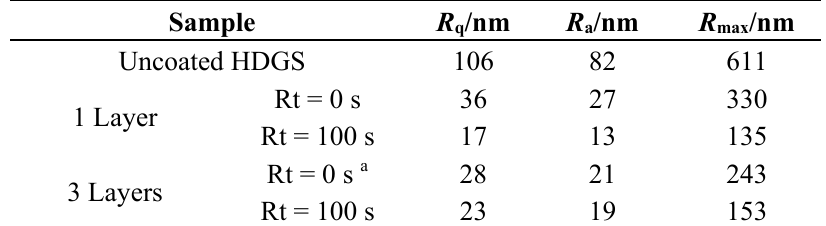
Table 3. Roughness parameters obtained for uncoated (control) and the HDGS samples coated with one and three